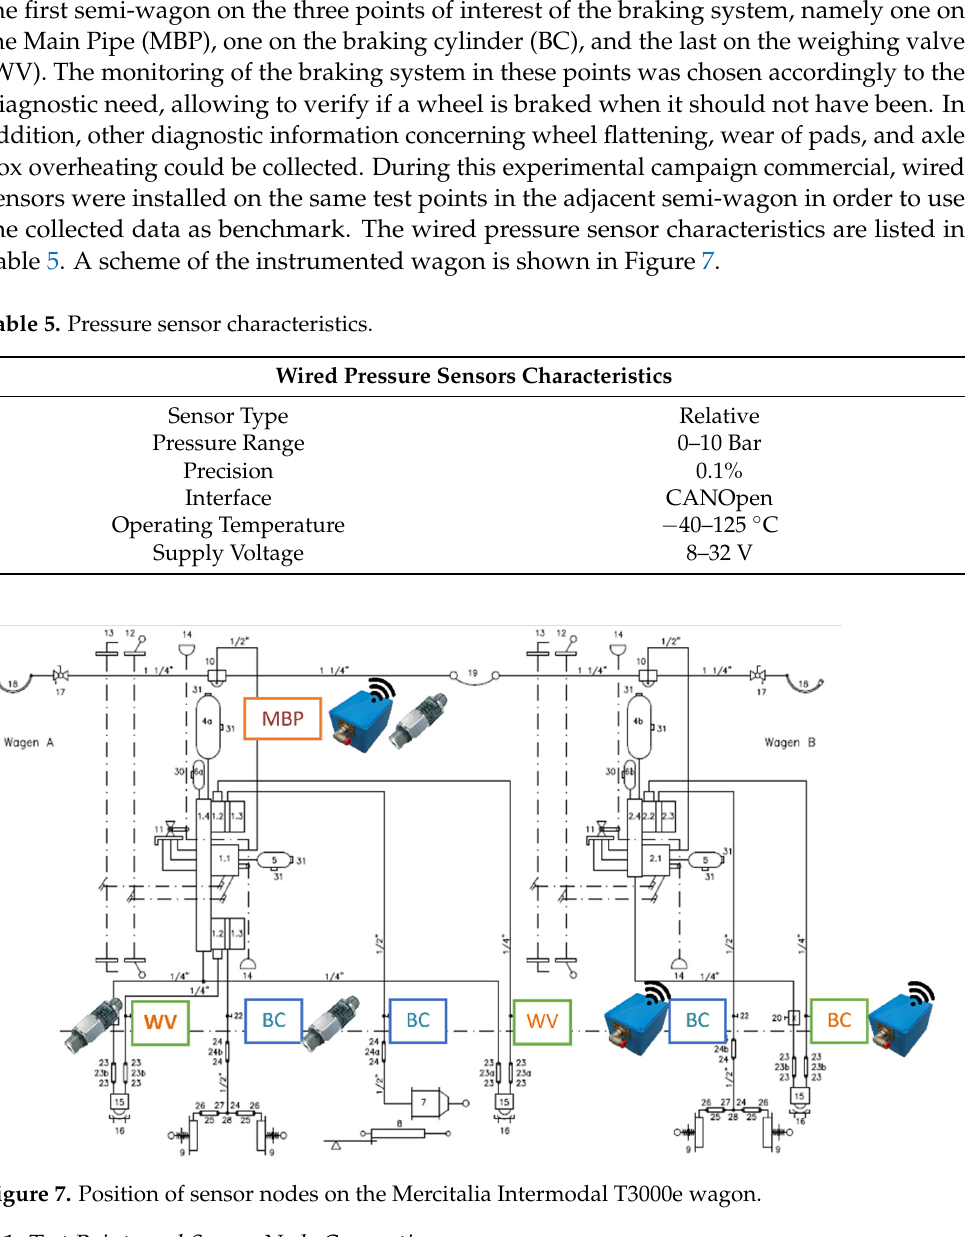
Figure 7. Position of sensor nodes on the Mercitalia Intermodal T3000e wagon. Table 5. Pressure sensor characteristics.